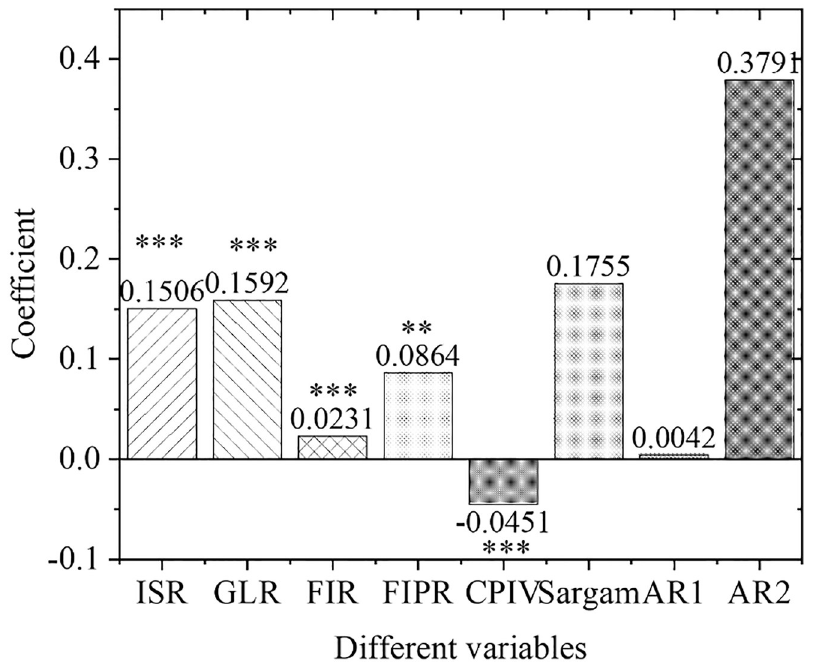
Fig 7. Estimation results of empirical panel coefficient in eastern China.